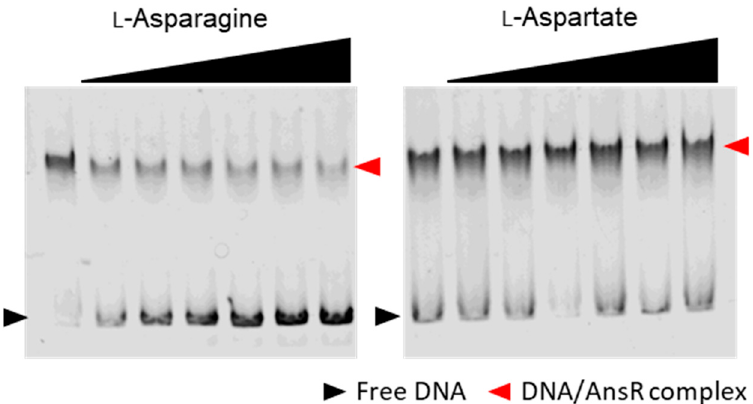
Figure 6. Investigation of effector molecules of AnsR. AnsR was incubated with L-asparagine or L-aspartate prior to the incubation with the DNA probe. The concentrations of the amino acids were 0, 0.2, 0.4, 0.8, 1.0, 2.0, and 5.0 mM. Free probes and AnsR-DNA complexes are indicated with black and red arrowheads,